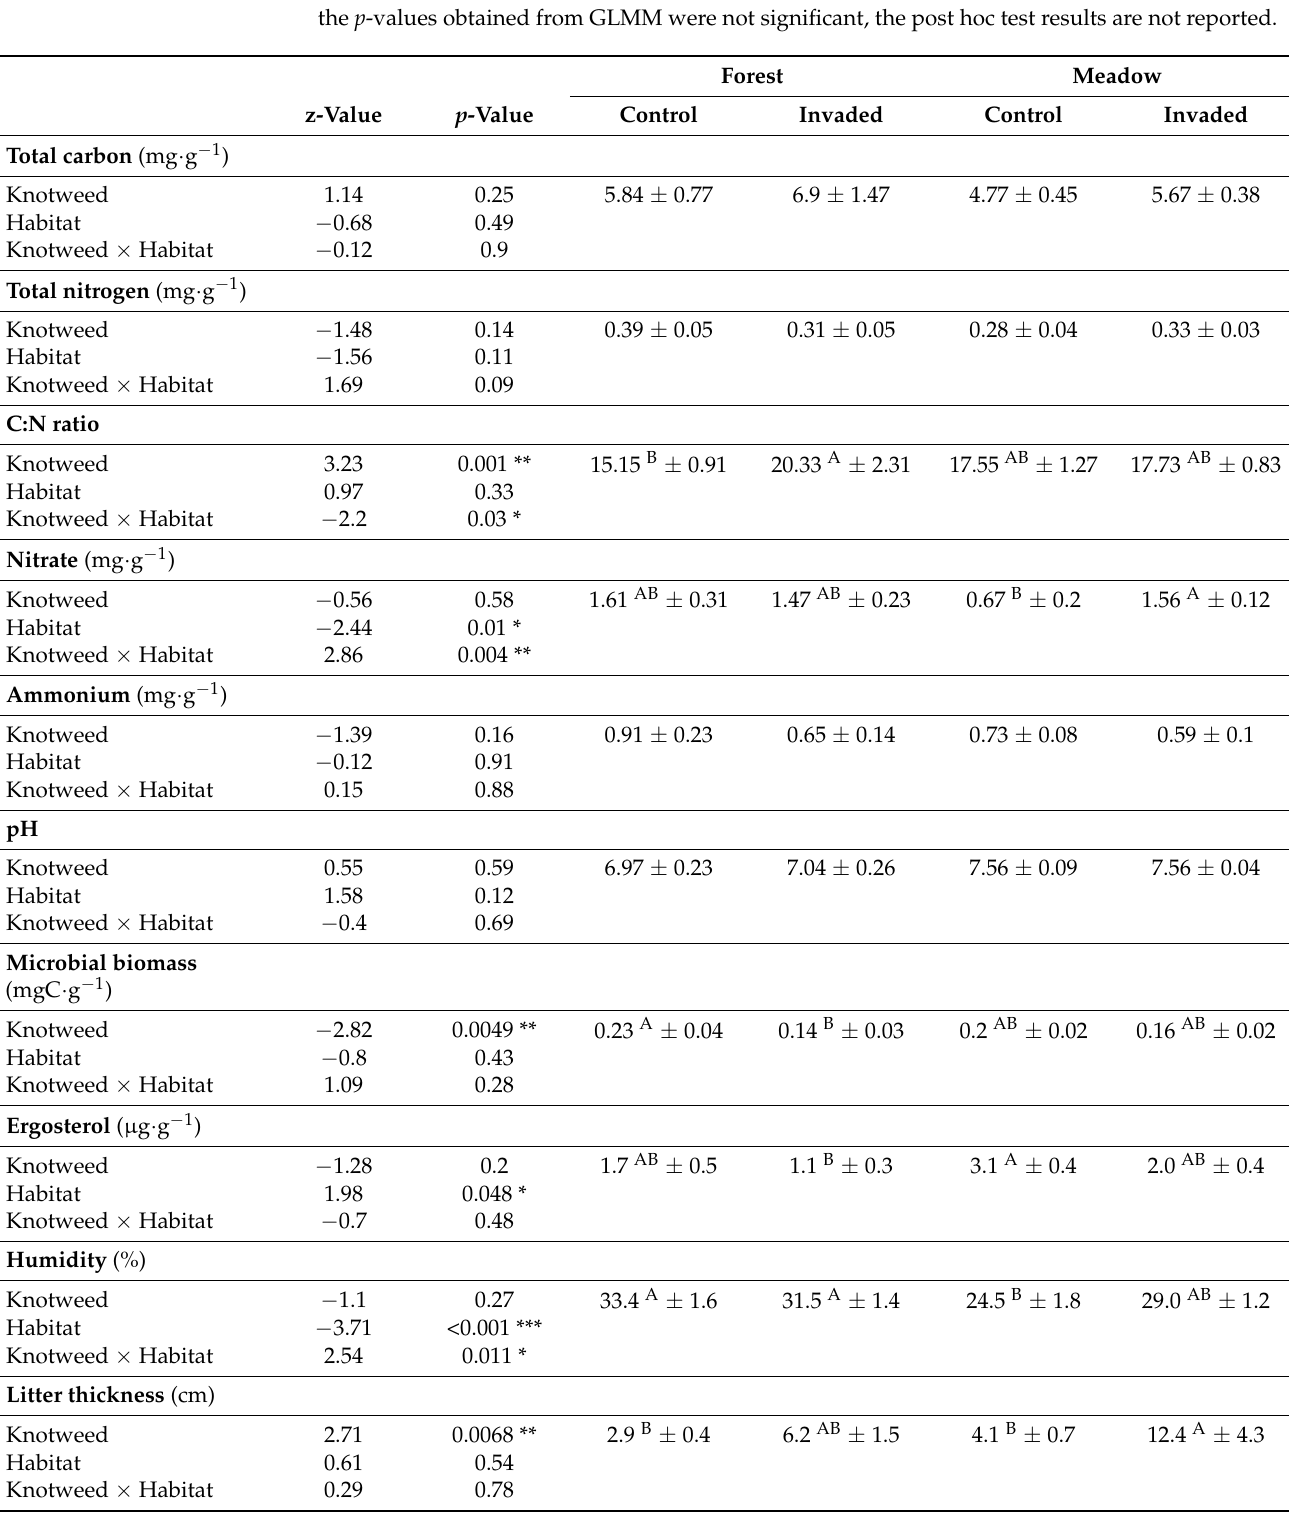
Table 1. Effects of the factors “Knotweed” with two levels: presence or absence, “Habitat” with two levels: forest or meadow, and their interaction on soil variables. Values are means ± standard errors. z-values and associated p -values were obtained from GLMM with gamma or Gaussian distributions. Two values in the same row with a different letter are significantly different according to Tukey post hoc tests. *, **, and *** denote statistical significance at p = 0.05, 0.01, and 0.001, respectively. When the p -values obtained from GLMM were not significant, the post hoc test results are not reported.